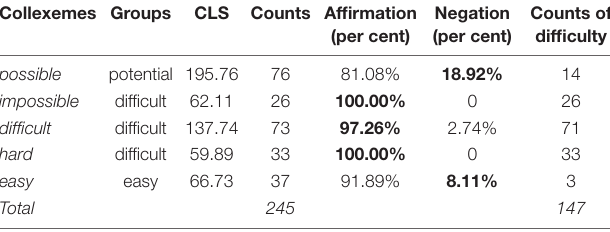
TABLE 4 | The groupings of Ease-of-Performance